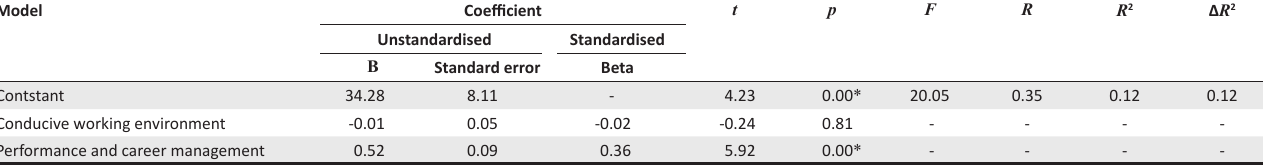
TABLE 6: Moderated regression analysis with reward subscales as predictors of work engagement.